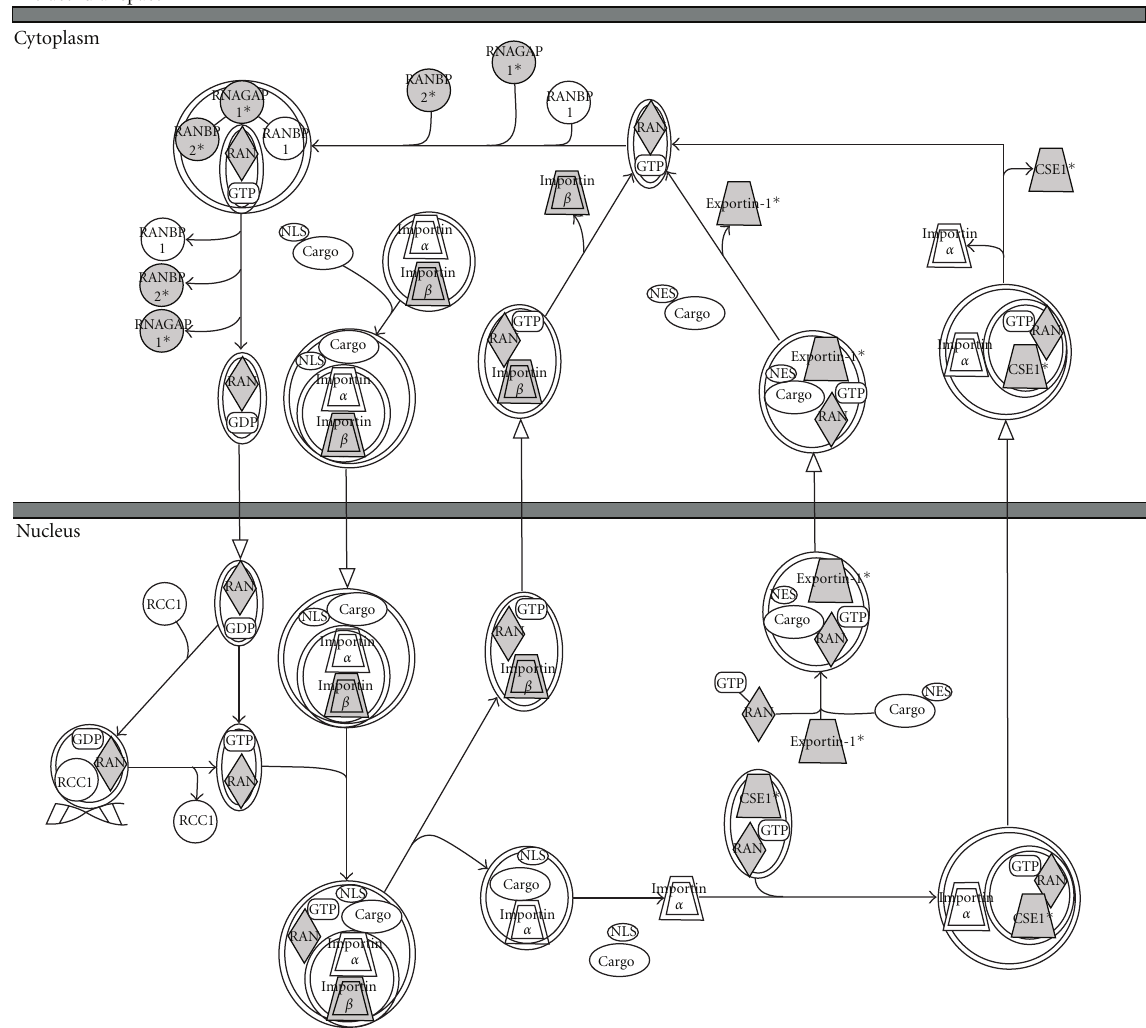
Figure 5: Integrated view of the role of SUMO in the Ran Signalling pathway. Ingenuity analysis of proteins that have been identified (in gray) in recent studies: KPNB1, CSE1L, TNPO1, RANBP2, RAN, XPO1, and RANGAP1 (Figure 4 and Supplementary Table 1) by mass spectrometry using